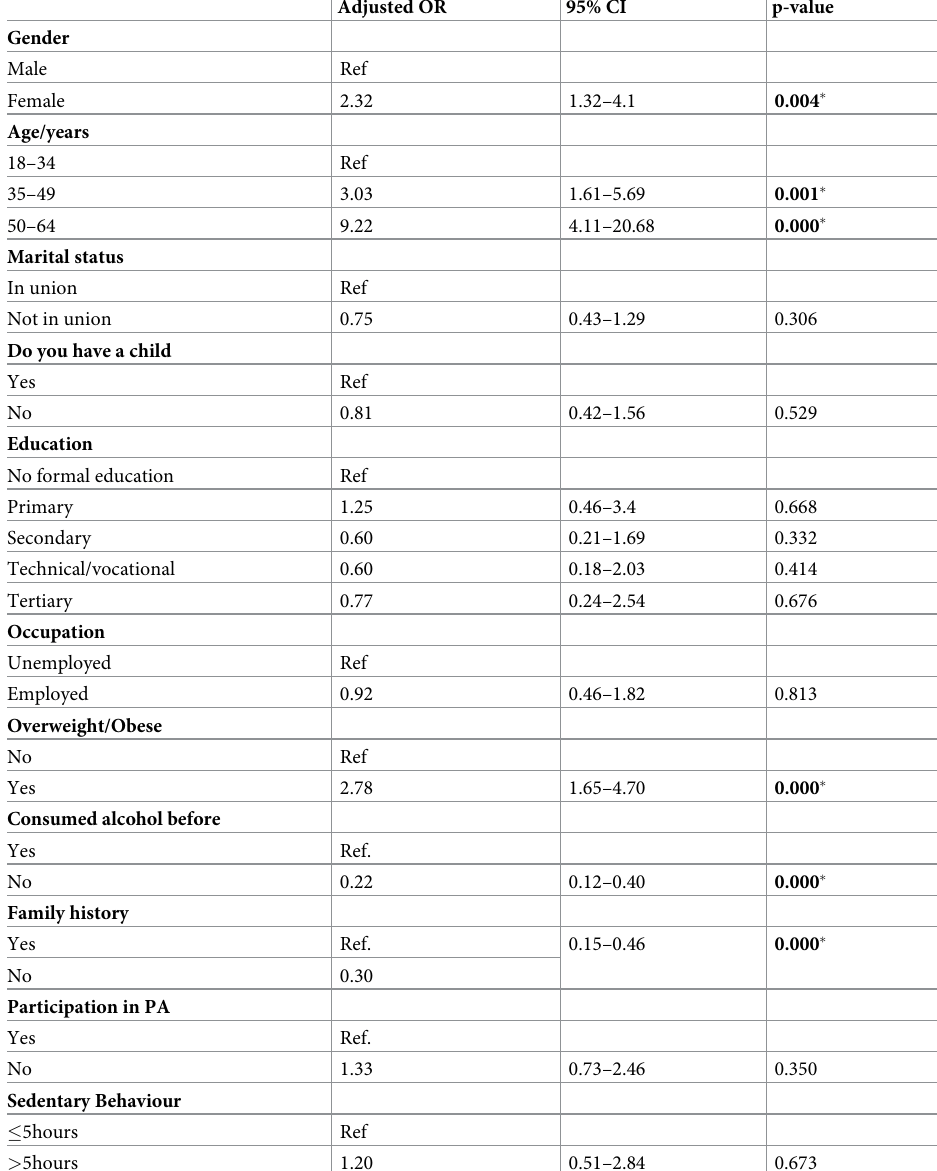
Table 5. Multivariate logistic regression to determine predictors of NCD risk factors (n =